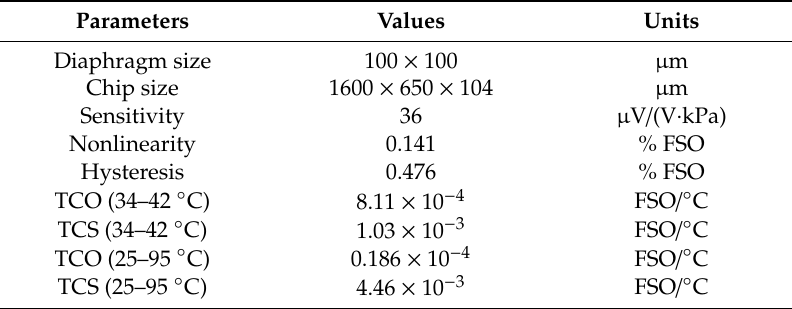
Table 2. Comparison with other miniature pressure